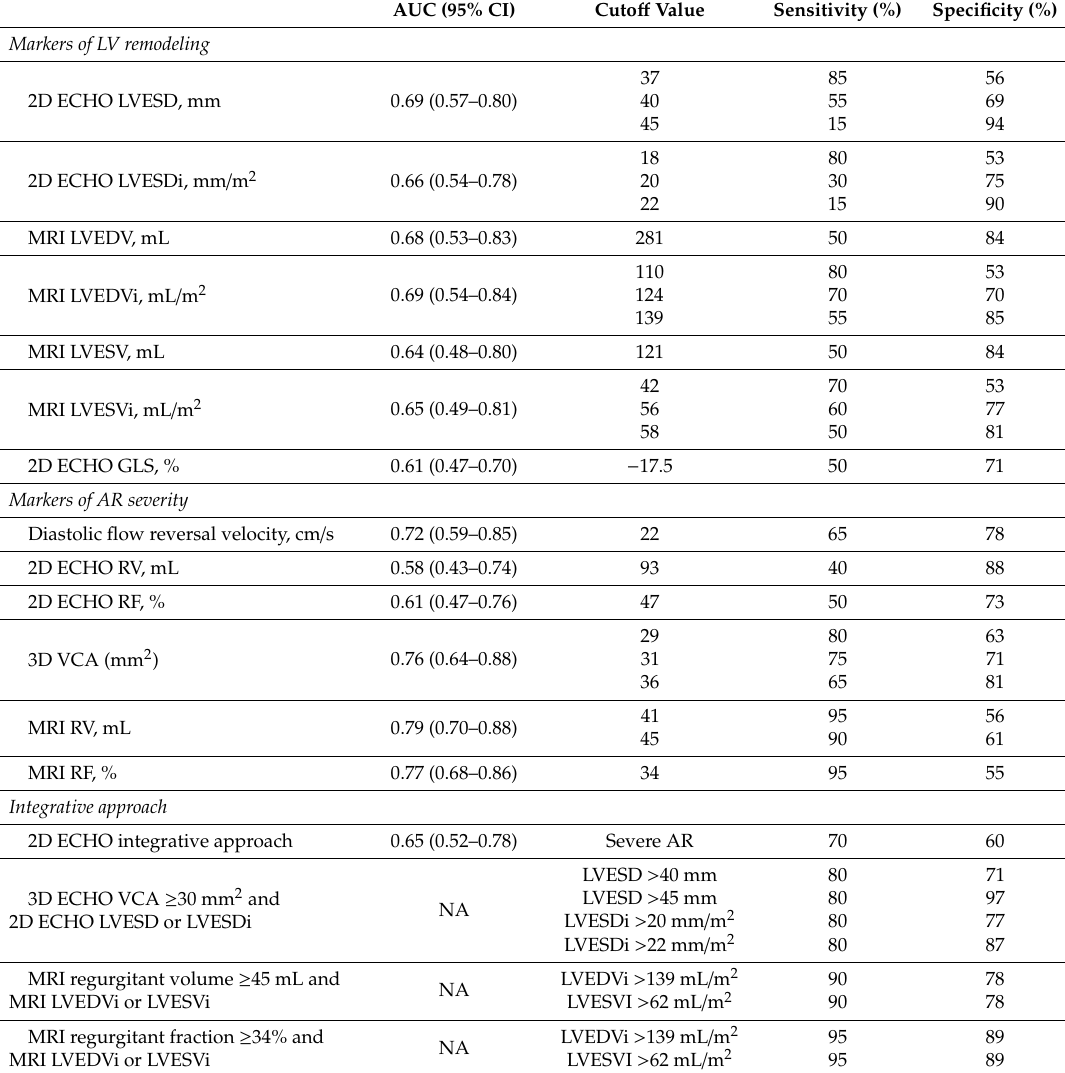
Figure 3. ( A ) Kaplan–Meier curves for aortic valve surgery (AVR) in patients with 3D ECHO-derived VCA ≥ 30 mm 2 vs. < 30 mm 2 , ( B ) MRI-derived RV ≥ 45 mL vs. < 45 mL; and ( C ) MRI-derived RF ≥ 34% vs. < 34%. Table 3. Predictive accuracy of selected imaging markers to identify patients undergoing AV